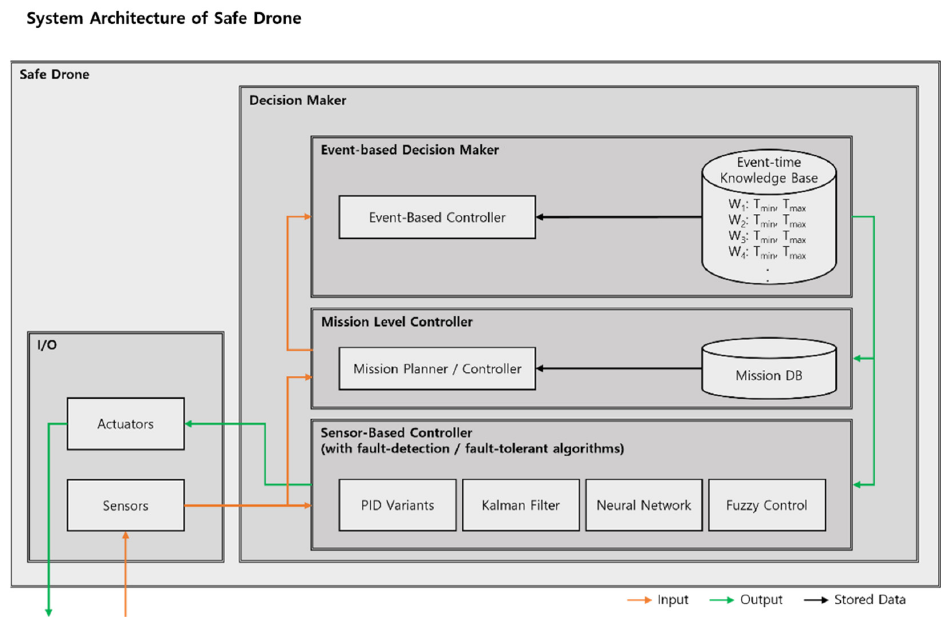
Figure 2. Proposed safe drone architecture. We mounted our event-based controller on top of low- level controllers and expanded the decision-making system. Inside the event-based controller, the knowledge base stores the time-window data (e.g., T min , T max ) for each waypoint that is used in path- traveling drone operations.